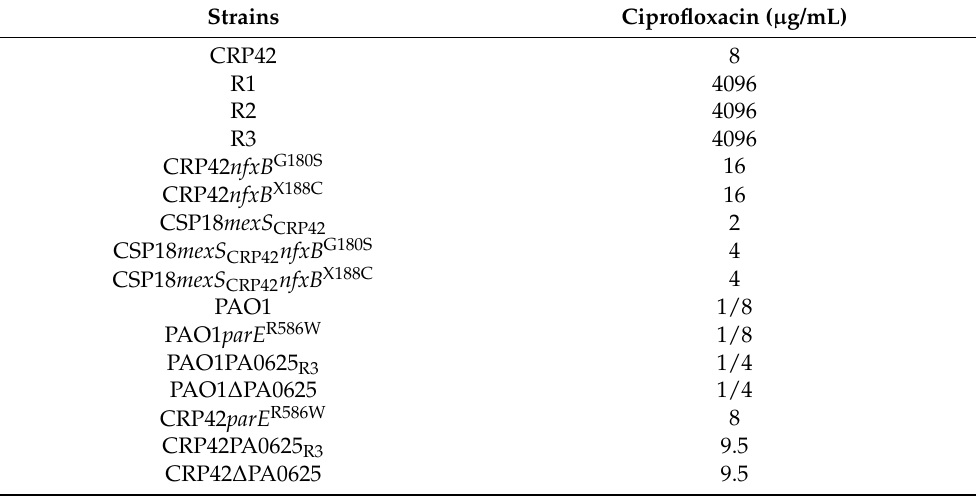
Table 1. MICs ( µ g/mL) of indicated P. aeruginosa strains.